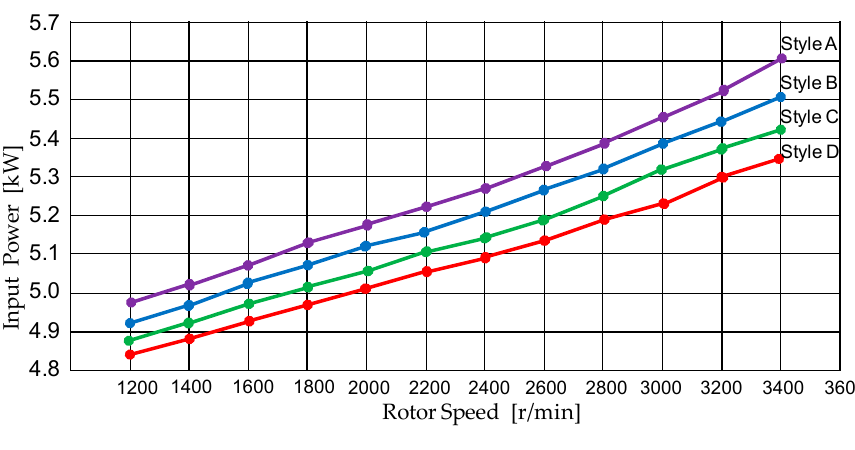
Figure 9. Poly-line graph of input power for four kinds of SCSCRIMs under several speeds.